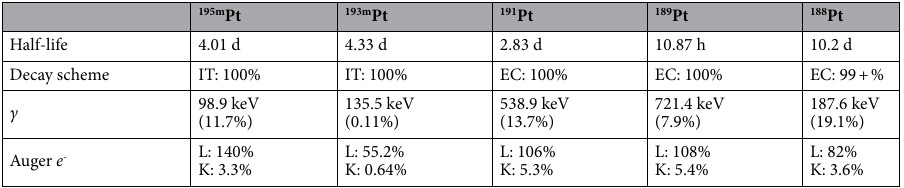
Table 1. Decay characteristics of relevant platinum radionuclides. Data for 188, 189, 193 m, 195m Pt were taken from NuDat 2.8 23 , and data for 191 Pt were taken from Radionuclide Decay Data 24